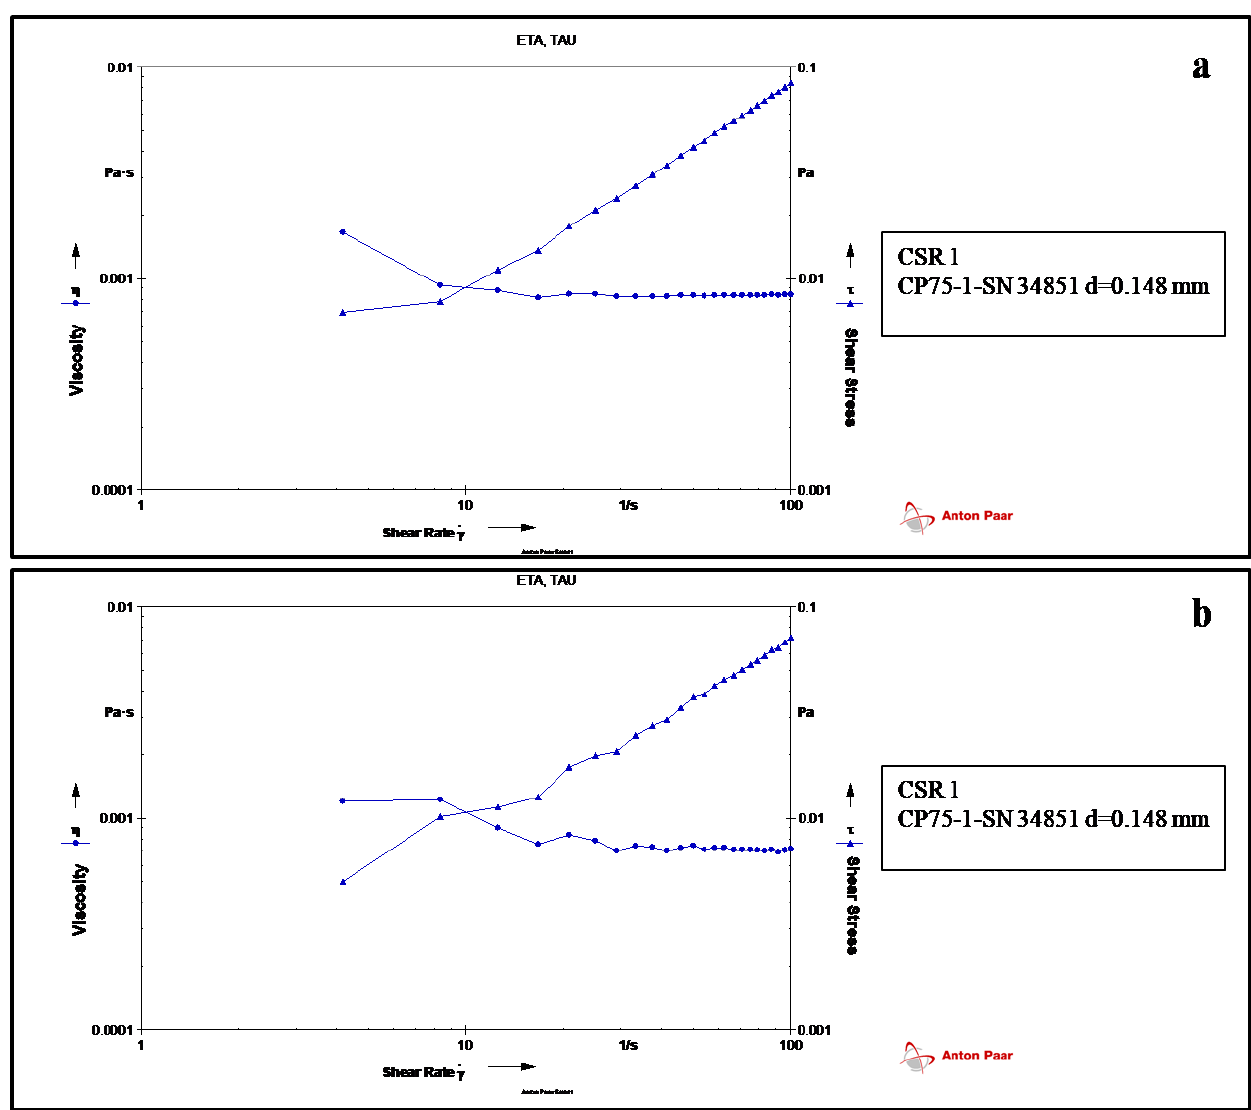
Figure 1. Rheology measurement displaying viscosity and stress of ( a ) dextran and ( b ) formulation (PD1).